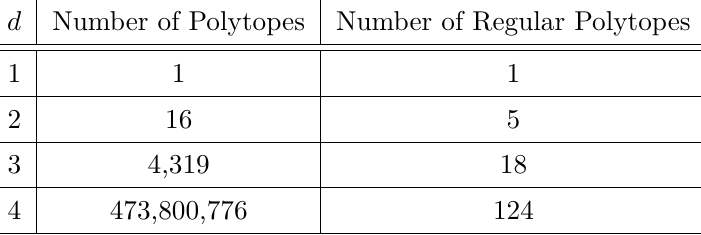
Table 1 . The number of distinct reflexive polytopes and distinct regular reflexive polytopes in dimension d ≤ 4